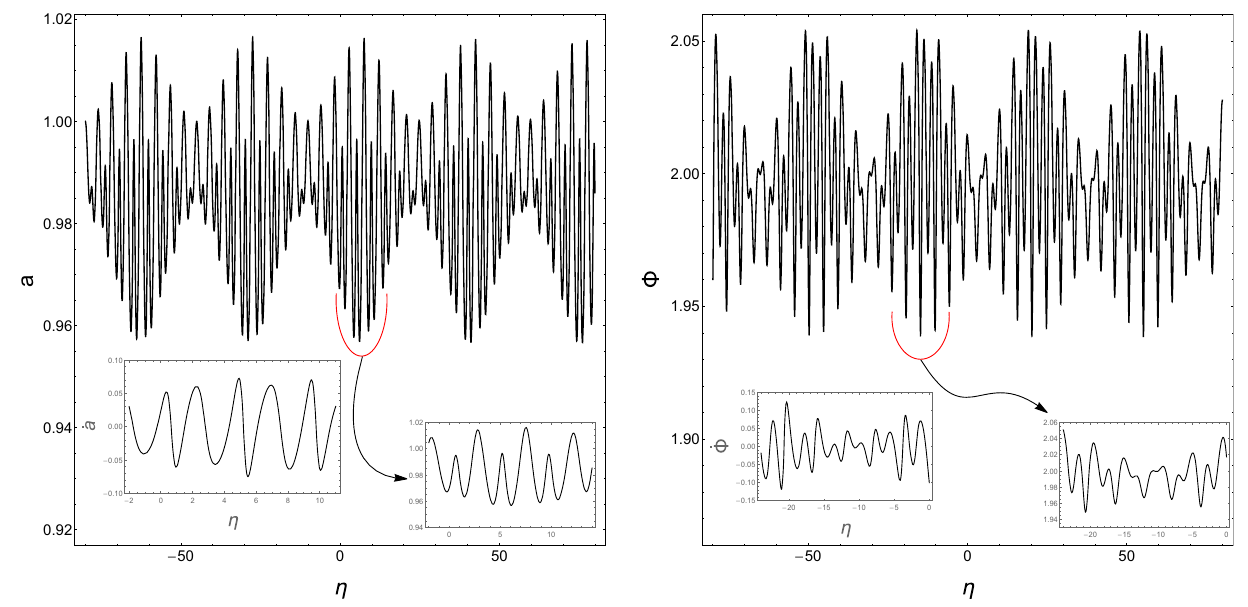
Fig. 6 Dynamical evolution of scale factor (left panel) and the BD scalar field (right panel) for γ = 1, ω = − 2 and r = − 34. The initial values for dynamical variables has been set as X 0 = Y 0 = 0,